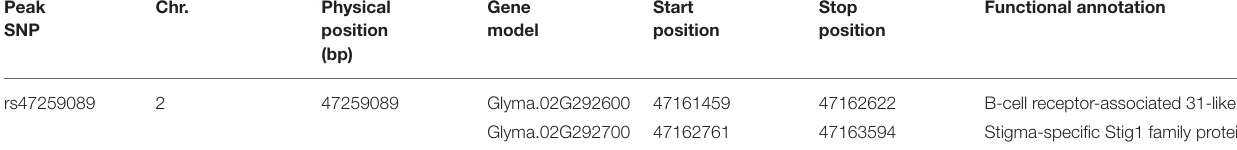
TABLE 3 | Gene models in the flanking regions of peak SNPs. Peak SNP